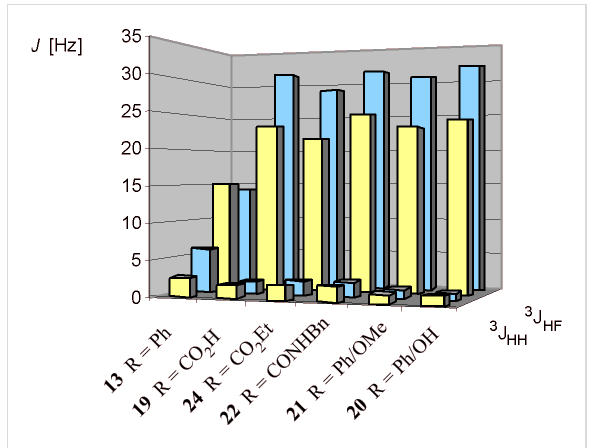
Figure 15: 3 J HF and 3 J HH coupling constants for the erythro (yellow) and threo (blue) diastereoisomers of the 2,3-difluorosuccinates 19–22, 24 as well as 1,2-difluoro-1,2-diphenylethanes 13 . NMR spectra were recorded in CDCl 3 with the exception of 2,3-difluorosuccinic acid, which was measured in CD 3 CN. The coupling constants were determ- ined from second order spectra.